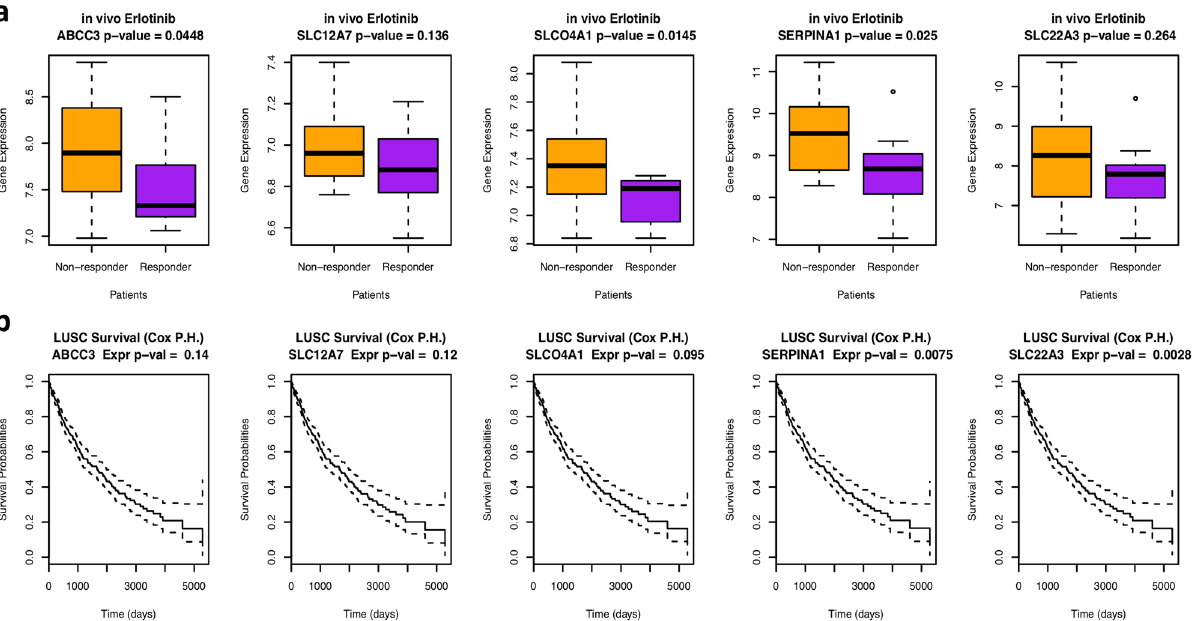
Figure 6. The expression values of the five potential transporters are different in the responsive vs. resistant patients and can predict patient survival. ( a ) Boxplot showing the difference in the expression values of the five potential transporters in the responsive vs. resistant patients in an erlotinib clinical trial (GSE33072). The p-value was computed from Student’s t-test by comparing the gene expression in responders versus nonresponders. ( b ) Cox proportional hazard survival analysis showing how expression values of different genes affect patient survival in the TCGA lung cancer data set, with p-values illustrating the significance of the